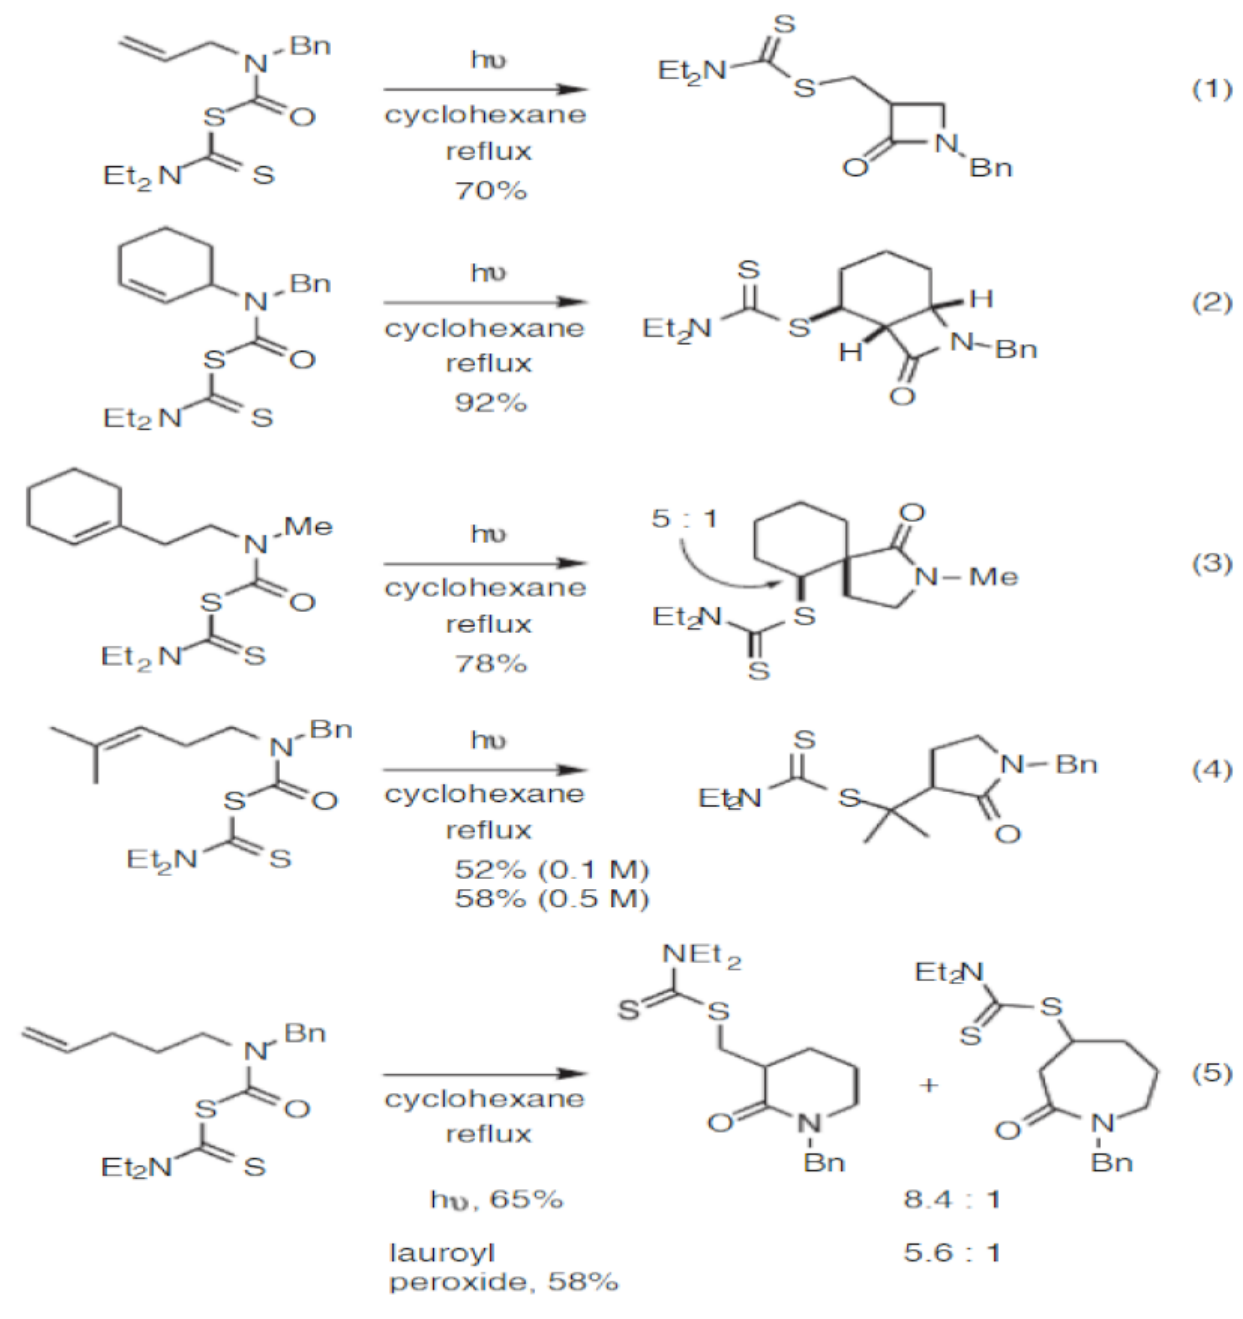
Figure 4. Synthesis of lactams (four-eight membered ring). Reprinted from [69]. Copyright (2007), with permission from Wiley and